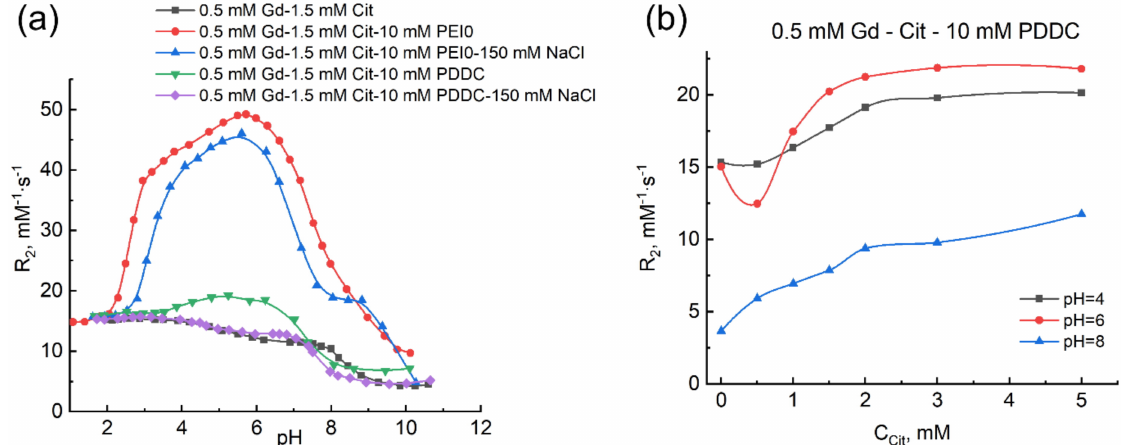
Figure 6. Dependence of relaxation effectiveness of solutions containing Gd 3+ ions and citric acid in the presence of PEI0 and PDDC on the acidity of medium ( a ) and on the concentration of citric acid in presence of 10 mM PDDC ( b ). C Gd(III) 0.5 mM, C H4L 1.5 mM, C PEI 5 mM ( a ) 10 mM ( b ), C PDDC 10 mM ( b ), C NaCl 150 mM ( a